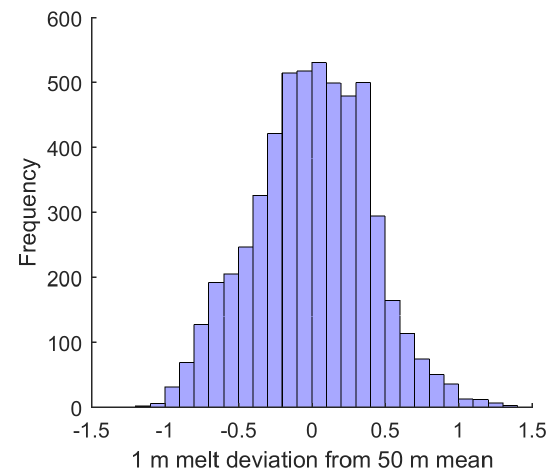
Figure 4. Histogram of deviation of 1m melt from 50m mean de- rived from terrestrial lidar scans of static ice front between 2012 and